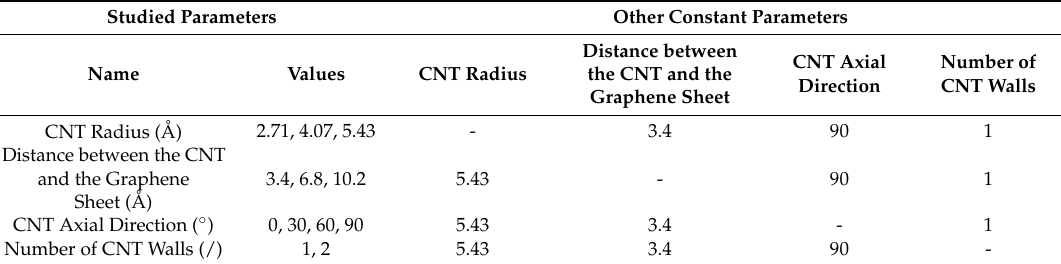
Figure 1. Chemical structures of DGEBA (epoxy monomer) ( a ), CHA (linker) ( b ), and view of the epoxy/graphene/CNT composite model ( c ). Table 1. Parameters used in different composite models.